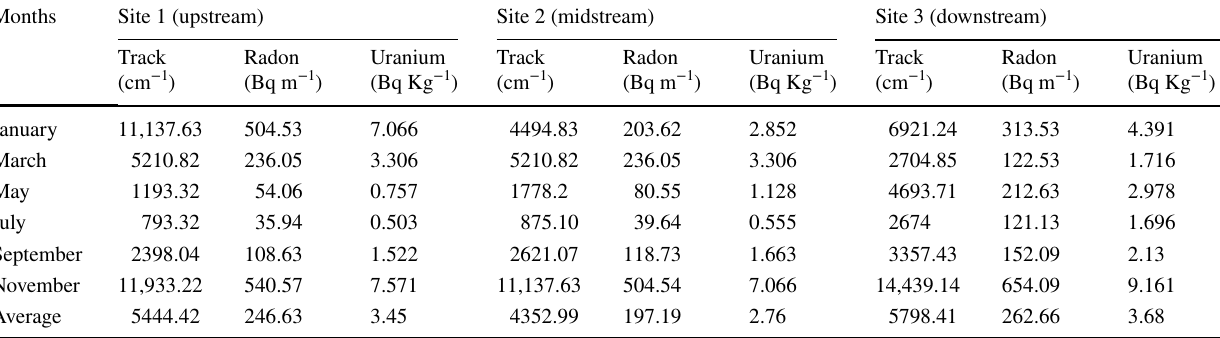
Fig. 2 CR-39 SSNTD’s detector used to measure radon exhalation Table 1 Alpha radioactivity level in sediment samples collected from Tigris